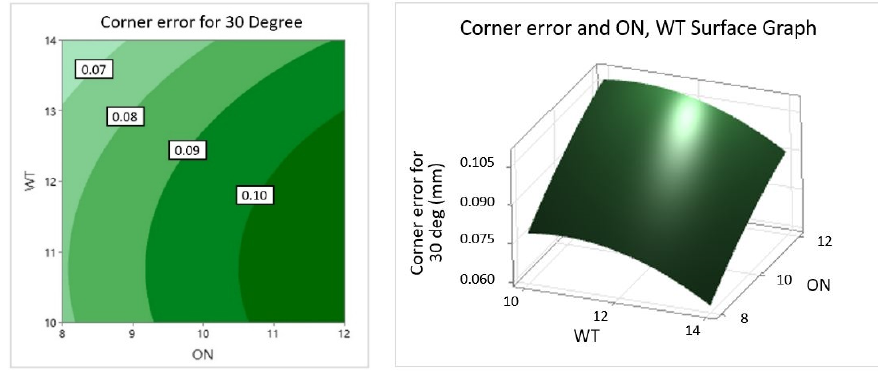
Figure 4. 2D contour and 3D surface plots corner error for 30° corner.